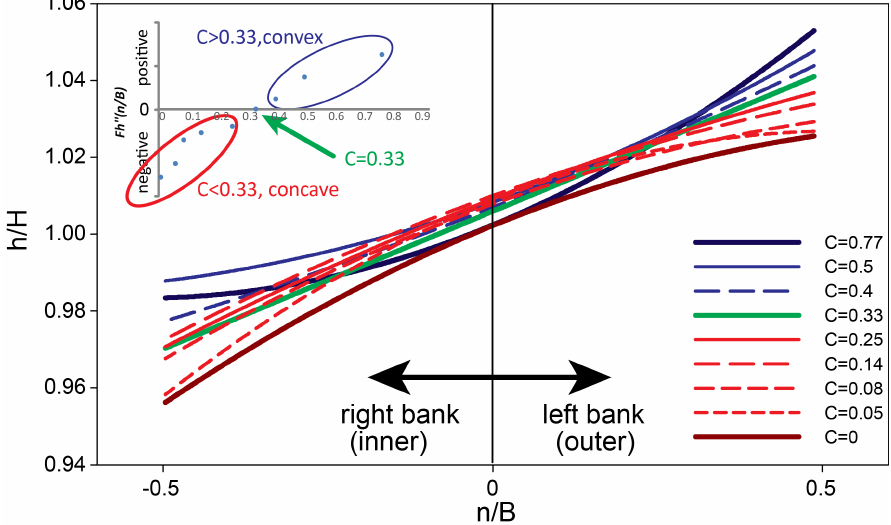
Figure 3. Normalized flow surface profiles for the nine simulations at the point bar apex 1.5 s / B . The insert plot shows the second order derivative of normalized flow surface elevation in the transverse direction, Fh (cid:48)(cid:48) ( n / B ) , which gives the convexity or concavity of the surface profile